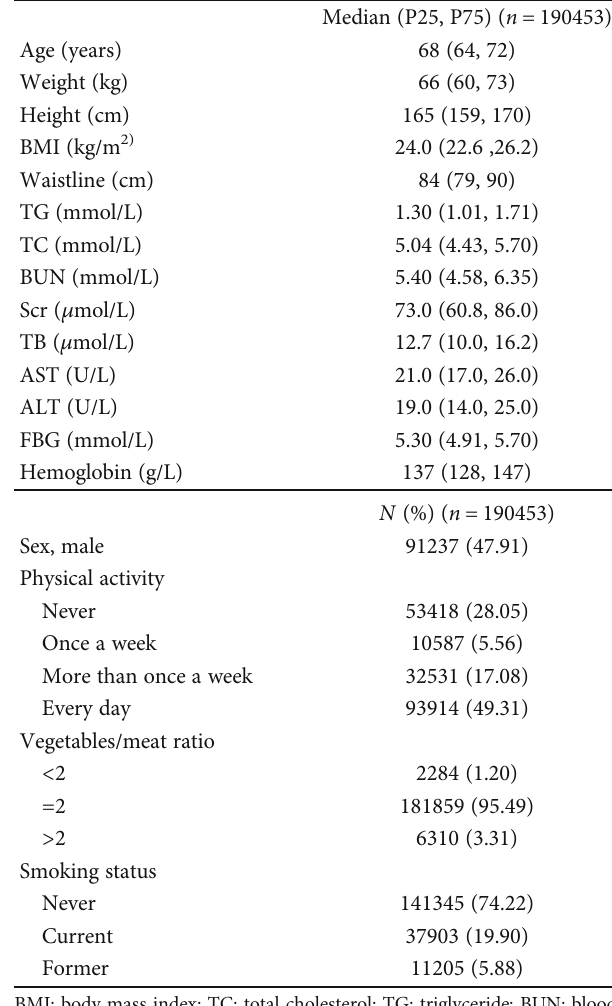
Table 1: The population characteristics at